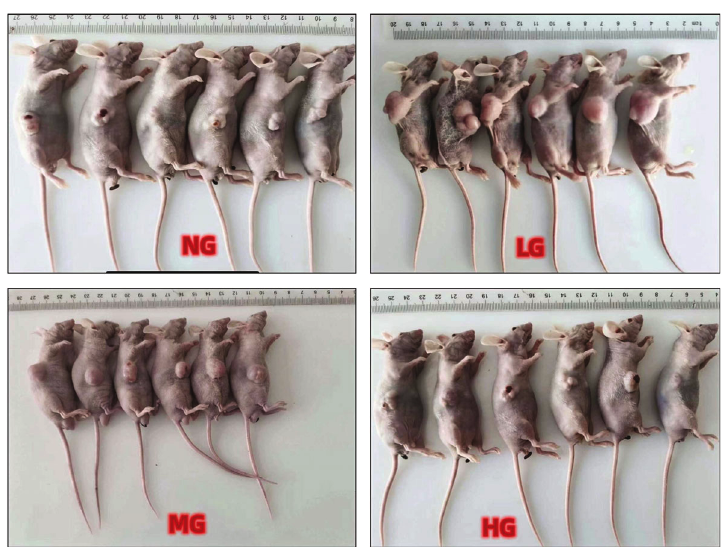
Figure 11: Inhibitory e ff ect of cervical recipe on tumor-bearing mice.